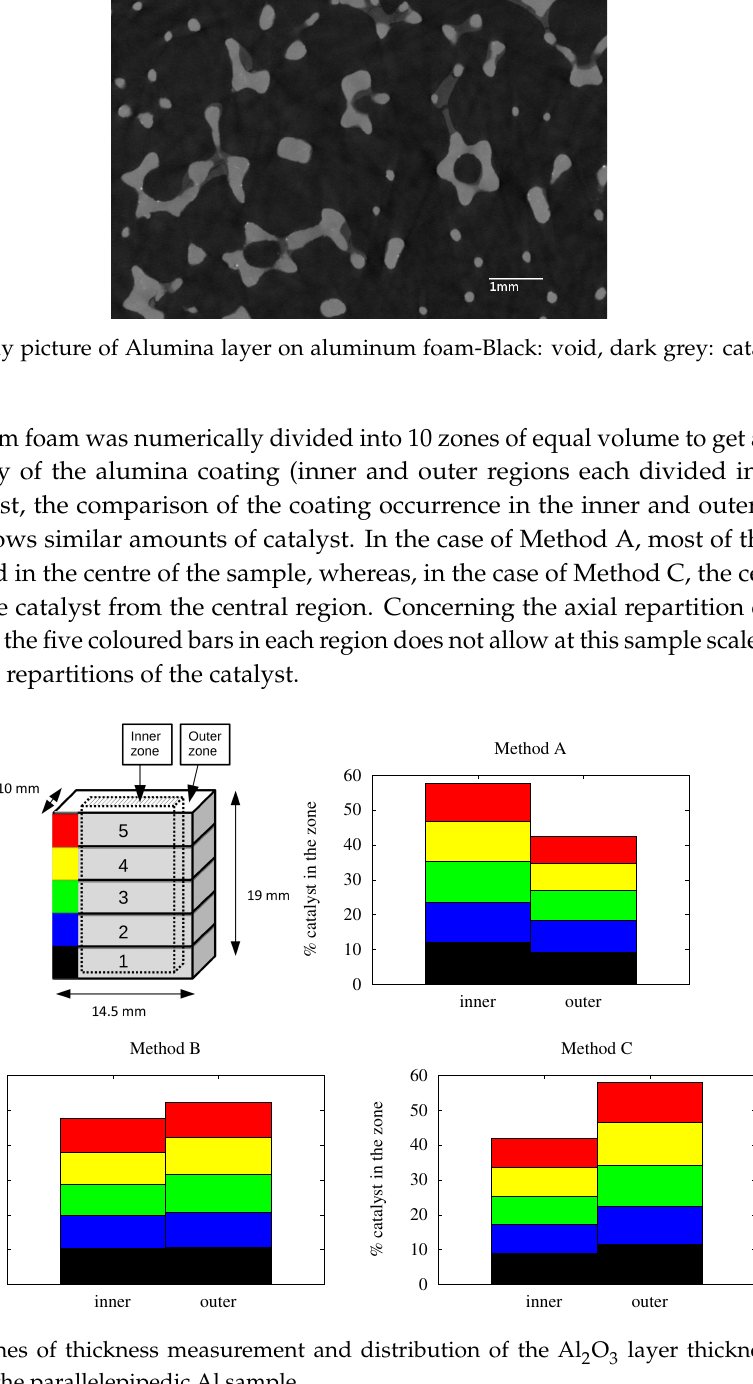
O layer thickness for the 2 3